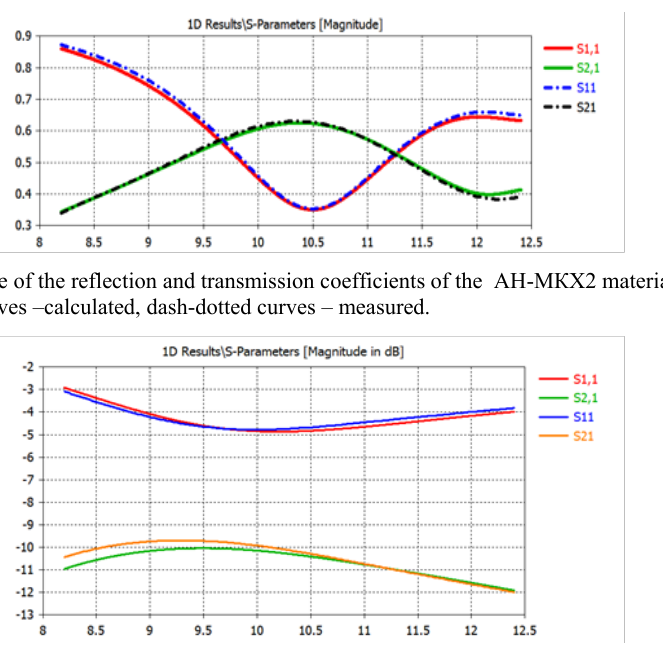
Fig. 4. The module of the reflection and transmission coefficients of the ПКМ - 35Ж material samples: red and green curves - calculated, blue and orange curves –